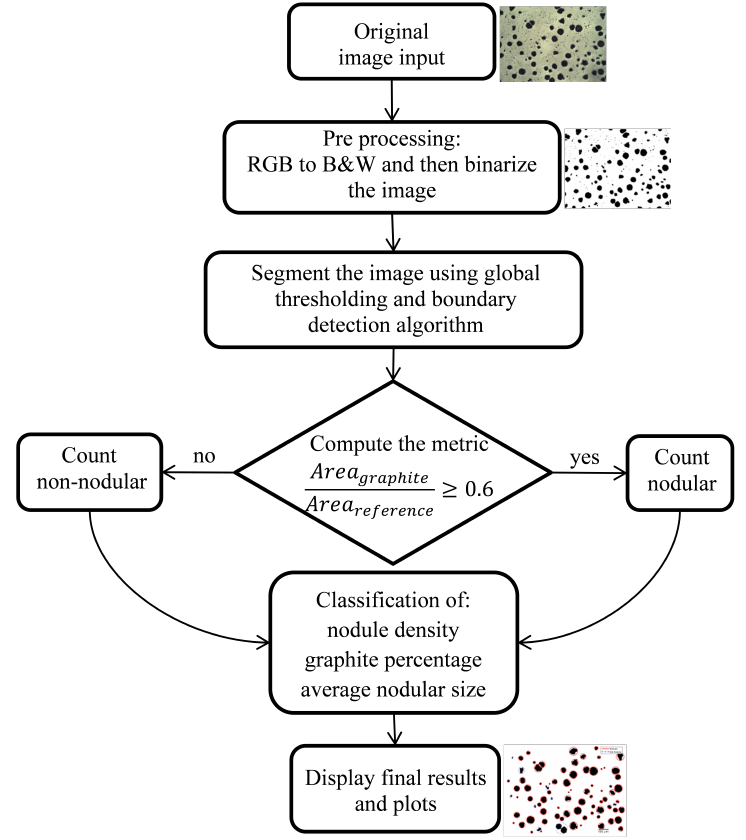
Figure 4. Nodule count algorithm flowchart.